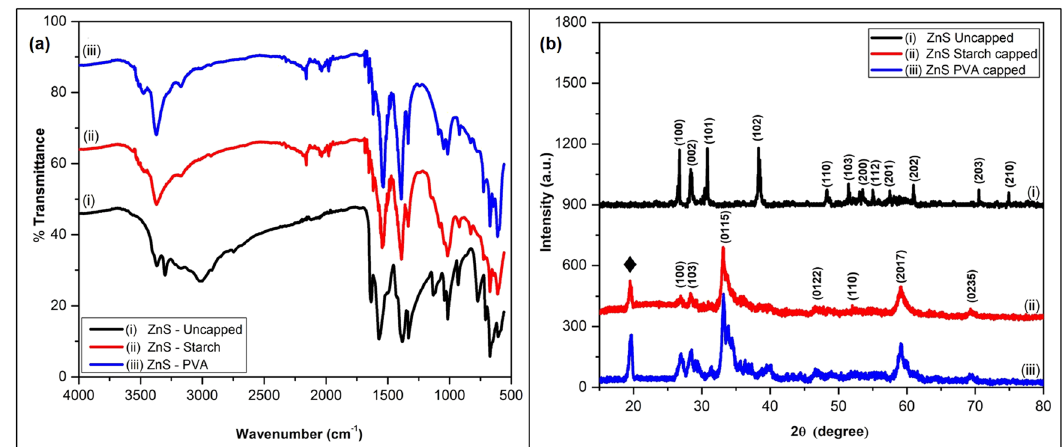
Figure 2: FTIR spectra ( a ) and X - ray di ff raction patterns ( b ) of ZnS uncapped ( i ) , starch - ( ii ) , and PVA - ( iii ) capped